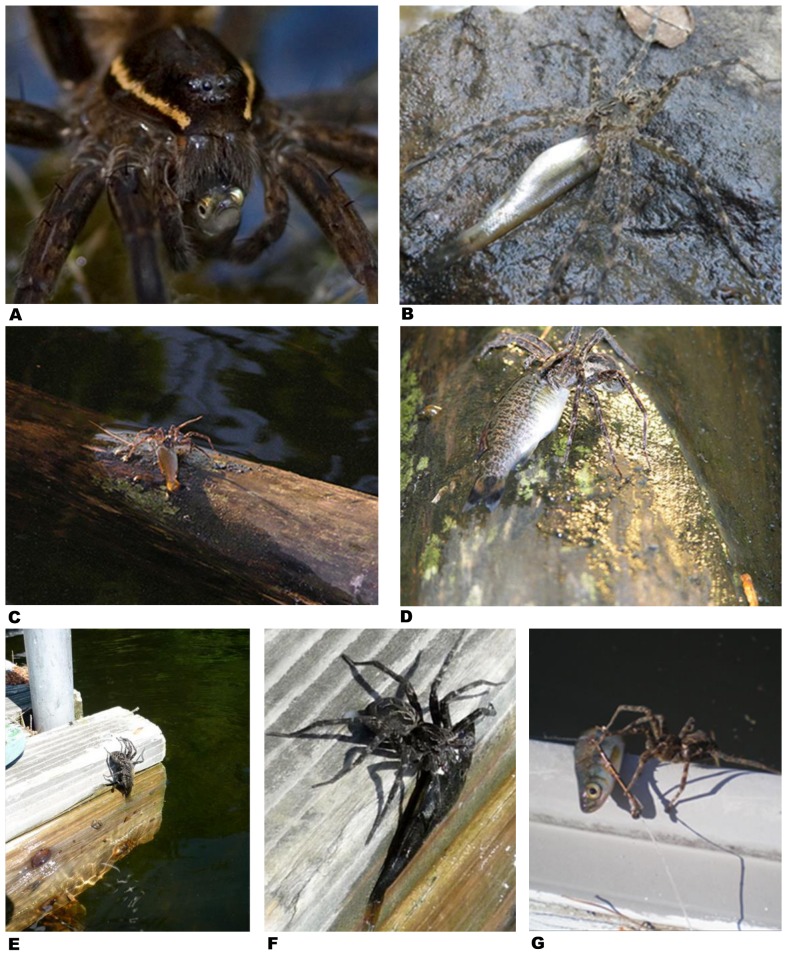
Fish caught by spiders – examples from North America.
A –
Dolomedes triton captured Sonora chub (Gila ditaenia) in small stream in Sycamore Canyon, Pajarito Mountains, Arizona (photo by Andreas Kettenburg, Thousand Oaks, California, USA; report # 9). B –
Dolomedes tenebrosus devouring creek chub (Semotilus atromaculatus) on bank of Bullskin Creek near Brutus, Kentucky (photo by Jason Butler, Lexington, USA; report # 33). C, D –
Dolomedes sp. caught smallmouth bass, Micropterus dolomieu, on shore of Flambeau River near Ladysmith, Wisconsin, USA (photo by Tod Lewis, Austin, Texas; report # 42). E, F –
Dolomedes scriptus feeding on fish (probably green sunfish Lepomis cyanellus) fished out of 1.8 m deep water on dock at Shoe Lake near Dorset, Ontario, Canada (photo by Lloyd Alter, Toronto, Canada; report # 46). G –
Dolomedes sp. scuttled out very quickly from underneath dock attempting to attack live bait fish (probably golden shiner Notemigonus crysoleucas) after a mis-cast resulted in bait fish landing just off edge of dock near Sebago Lake, Maine, USA (photo by Jeffrey Hollis, East Haddam, Connecticut, USA; report # 40).